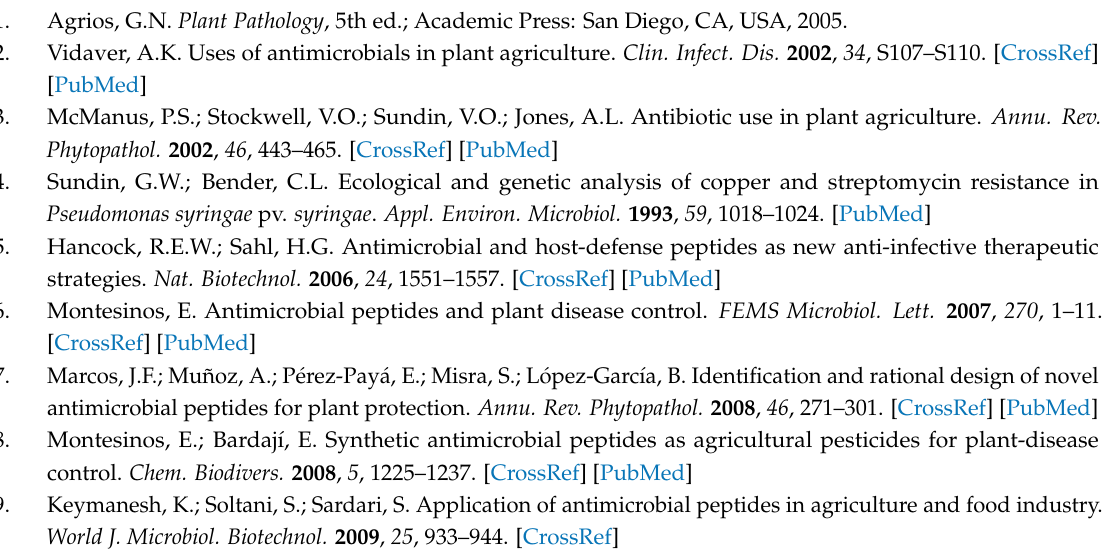
Supplementary Materials: Supplementary Materials are available online. Table S1: Antibacterial activity (MIC) and cytotoxicity of cyclic peptides incorporating a